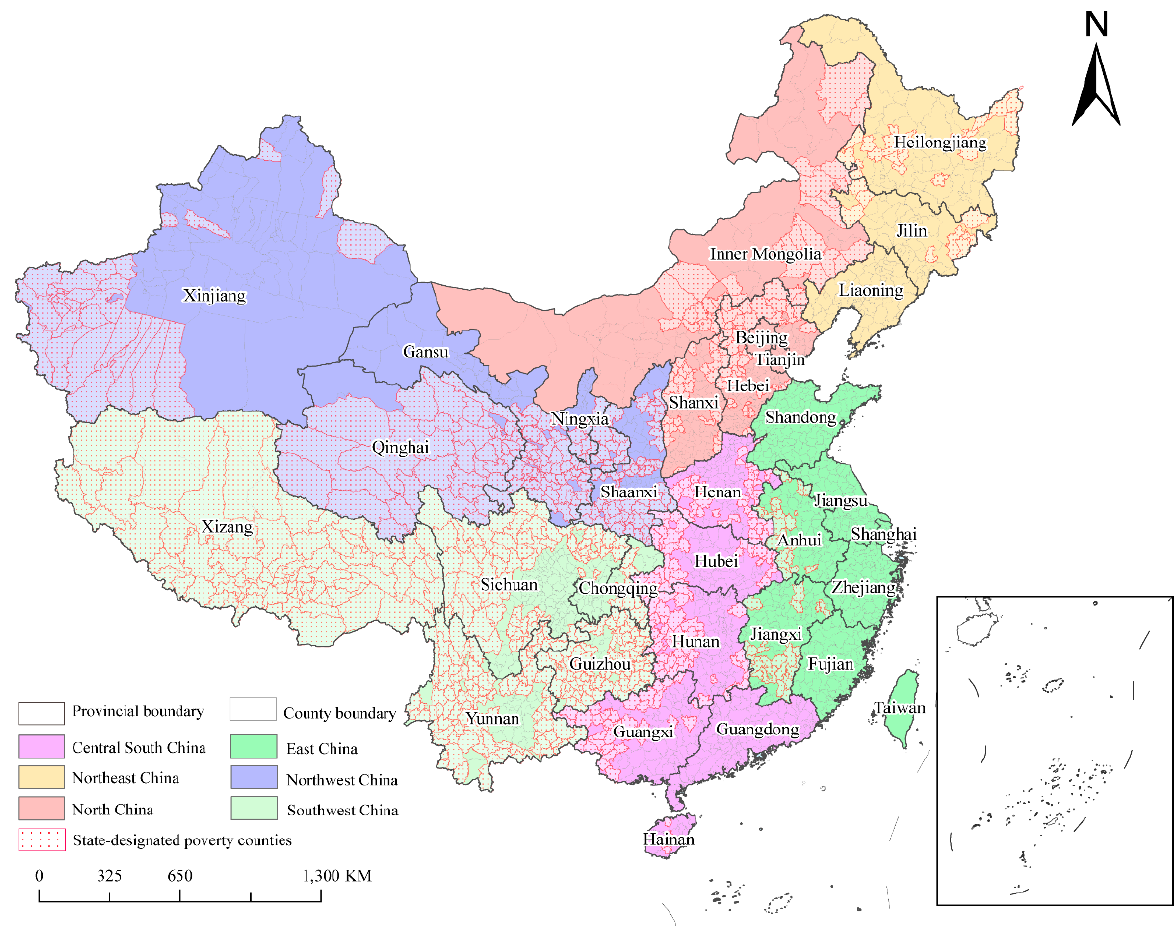
Figure 1. The geography of the 6 main regions and 832 state-designated poverty counties in China.